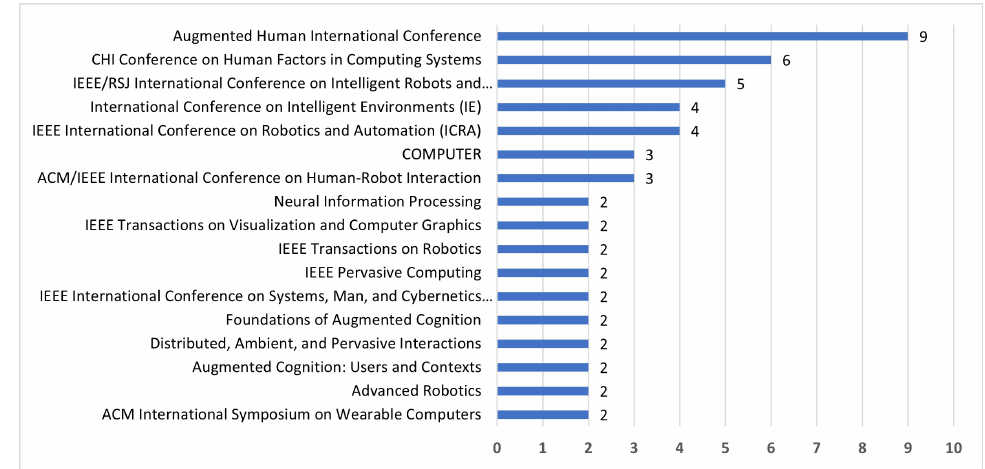
Figure 6. Publication venues of research